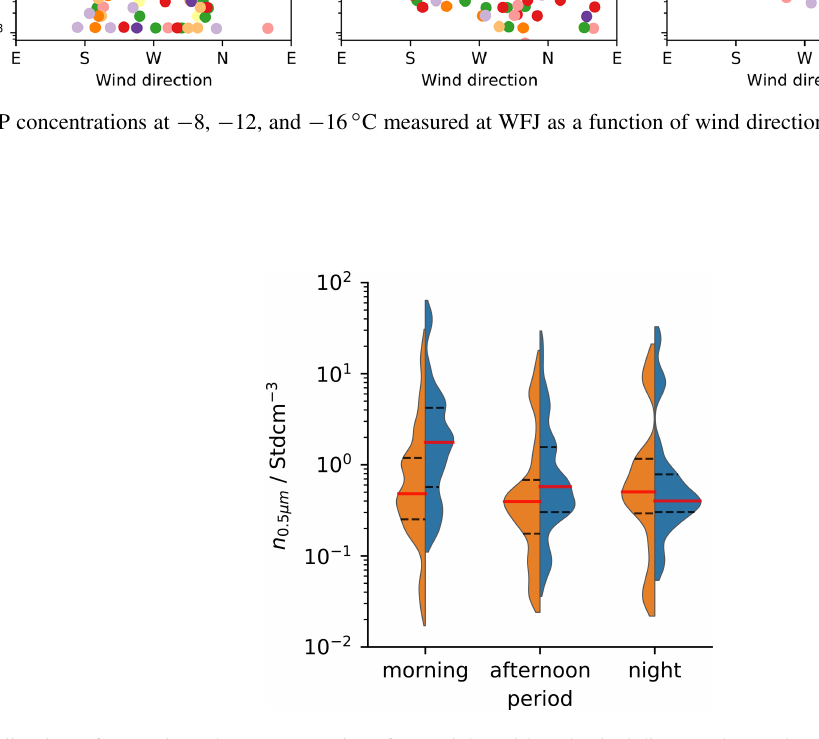
Figure A2. Violin plots of aerosol number concentrations for particles with a physical diameter larger than 0.5µm ( n 0 . 5µm ) at WFJ (orange) and WOP (blue) in the morning (03:00–11:59UTC), the afternoon (12:00–17:59UTC), and at night (18:00–02:59UTC). Only measurements that coincide with INP samples at each side have been